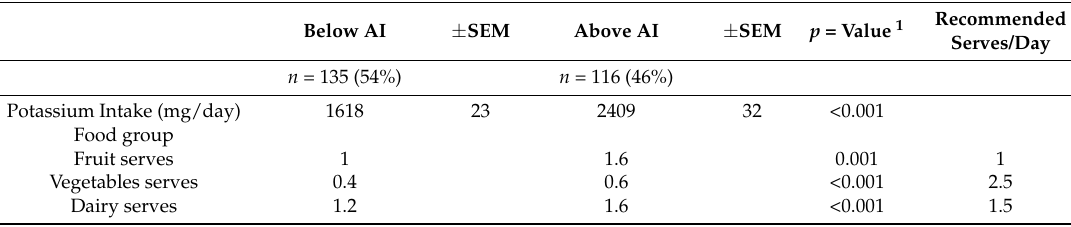
Table 4. Differences in serves of food groups by participants who did not meet the recommended AI for potassium (mean ( ±